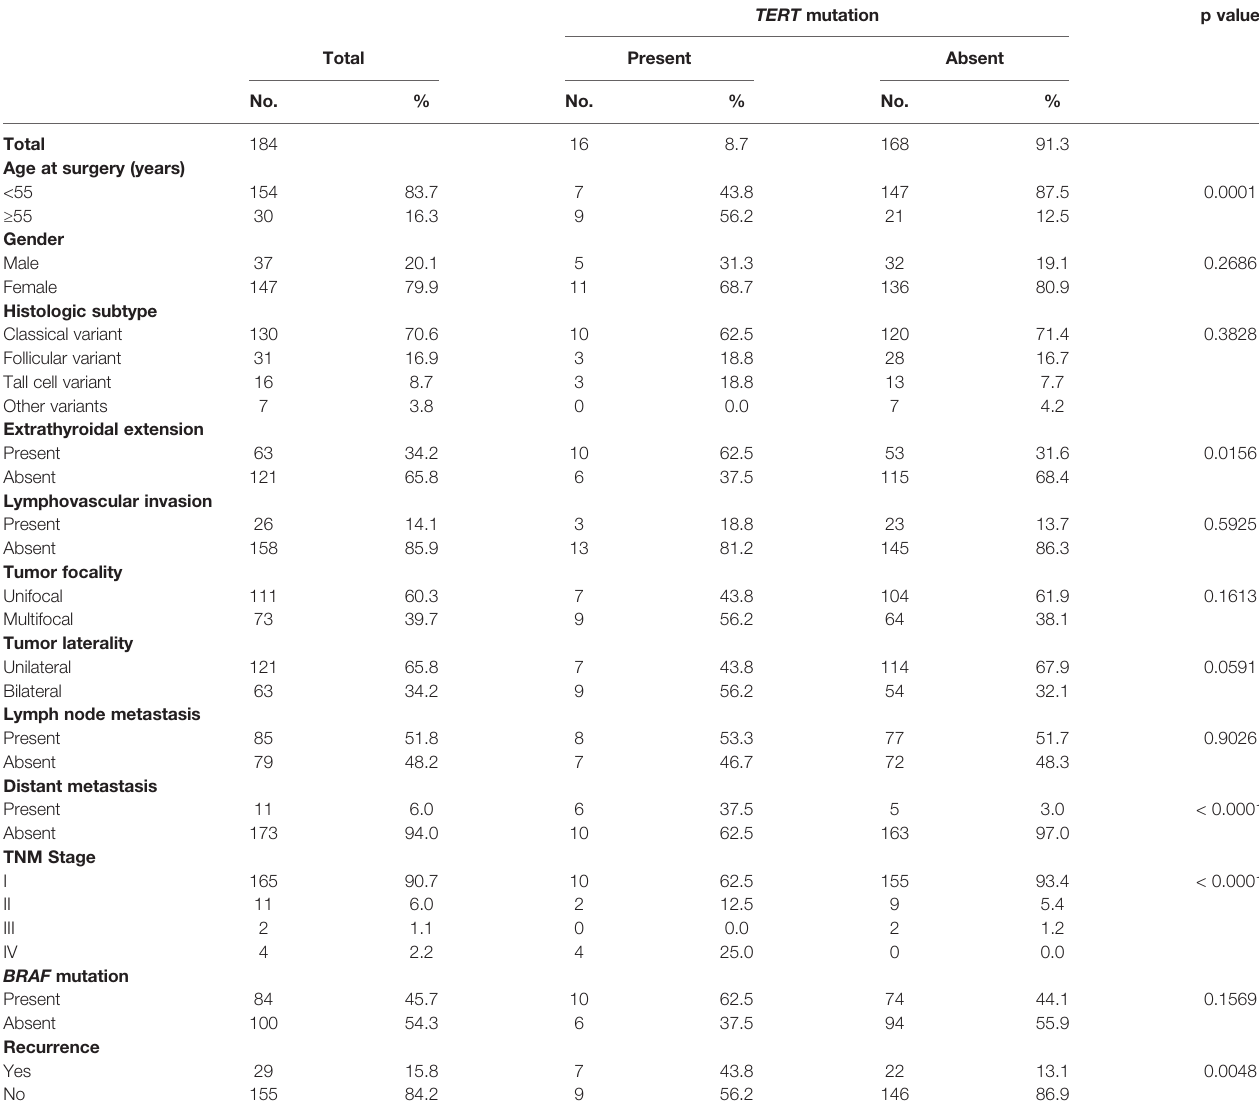
TABLE 3 | Clinico-pathological associations of TERT mutation in papillary thyroid